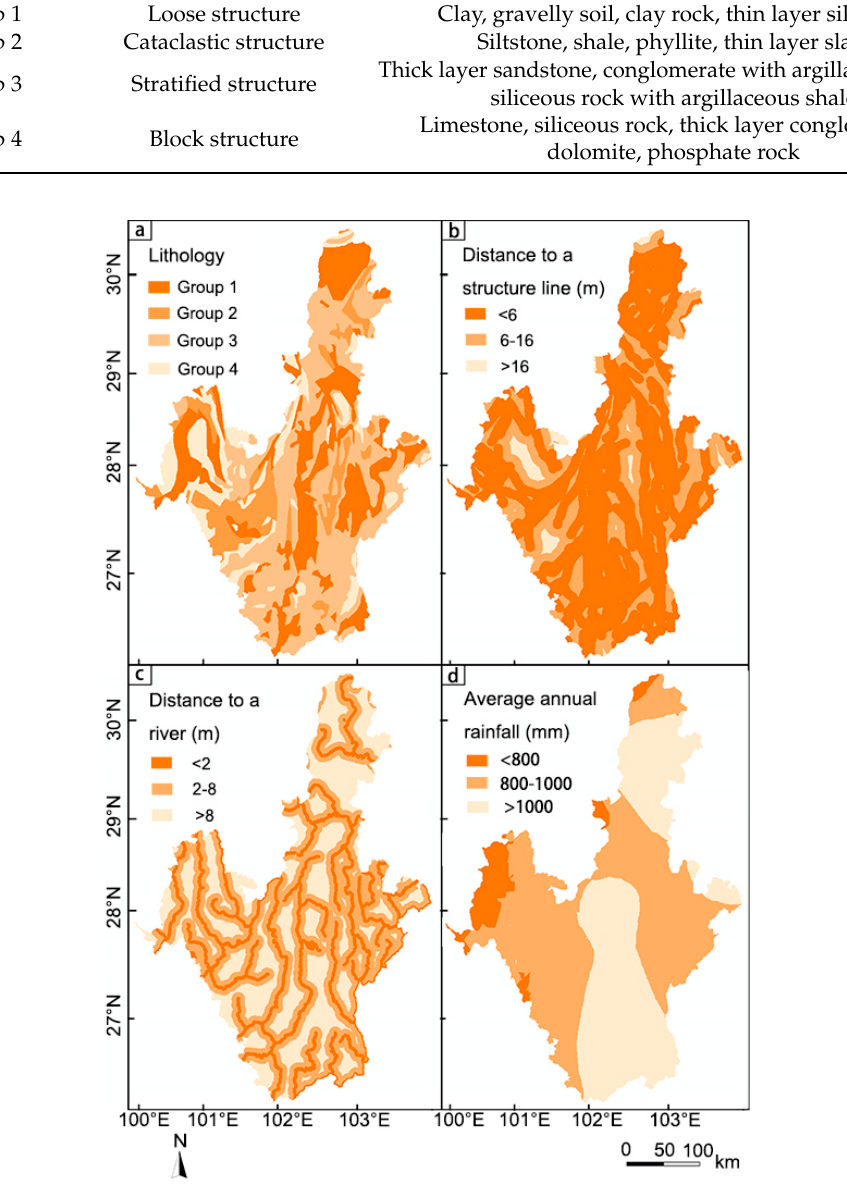
Figure 5. Zoning map of ( a ) lithology, ( b ) distance to a structure line, ( c ) distance to a river, ( d ) and average annual